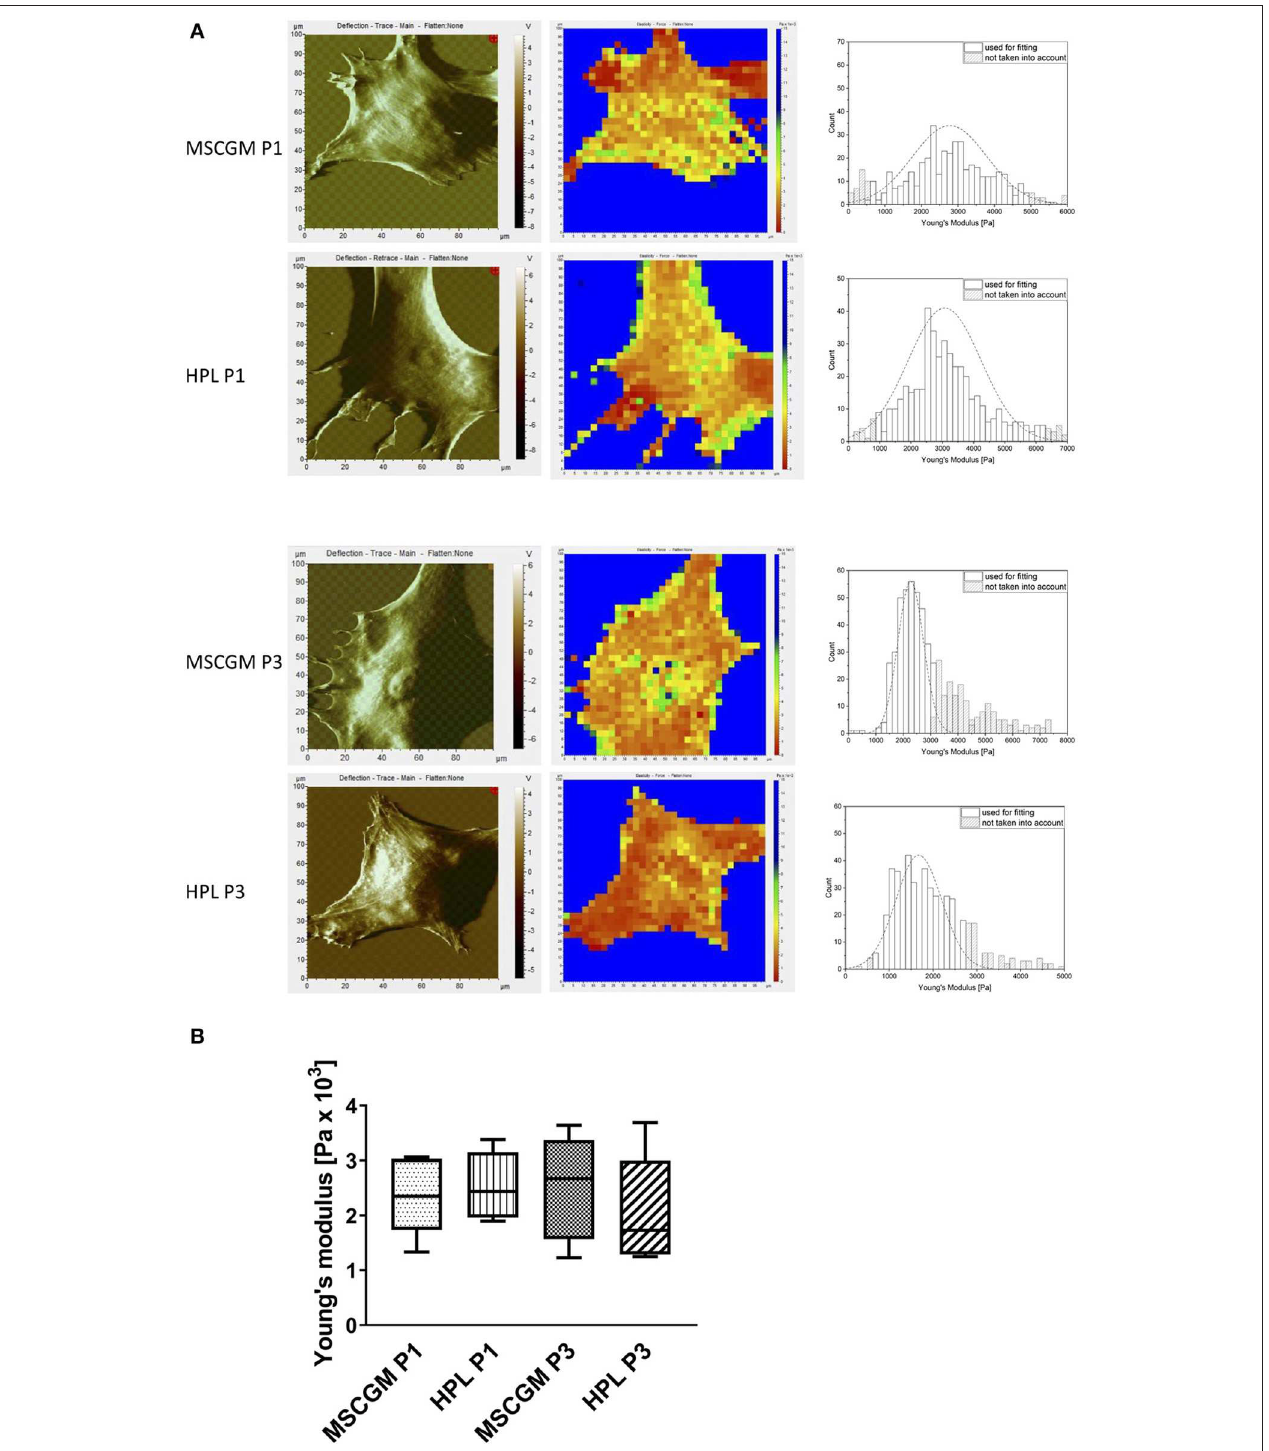
FIGURE 3 | Examination of elasticity. (A) Left: Topographic images of membrane structures from MSCs cultured in MSCGM TM or MSCBM TM with 8% HPL from passage 1 and 3 determined by atomic force microscopy. Middle: Elasticity mapping. Right: Surface elasticity measurements given by the Young’s moduli shown in a histogram. (B) Comparison of 1,024 single surface elasticity measurements from individual MSCs shown in a box plot diagram ( n = 6).